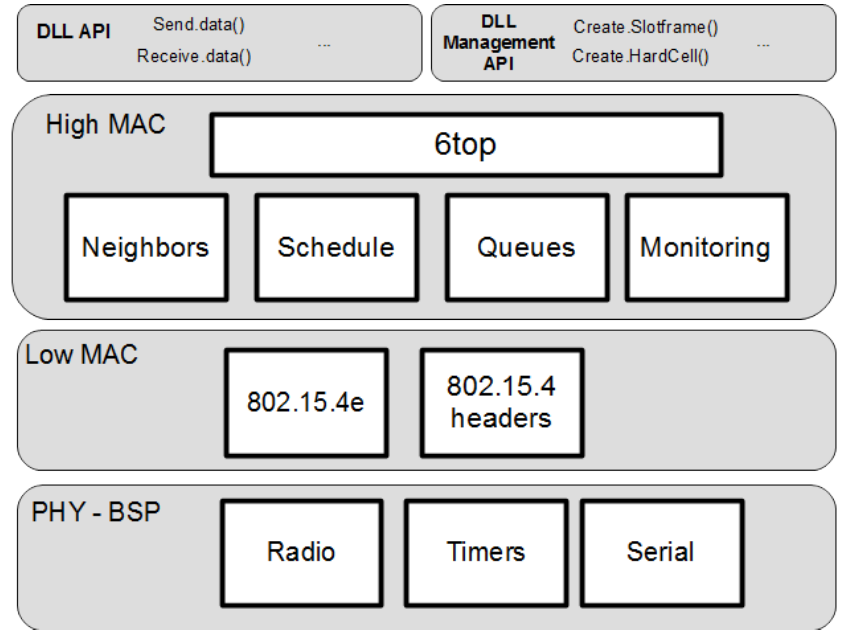
Figure 1. Component-based medium access control (MAC)